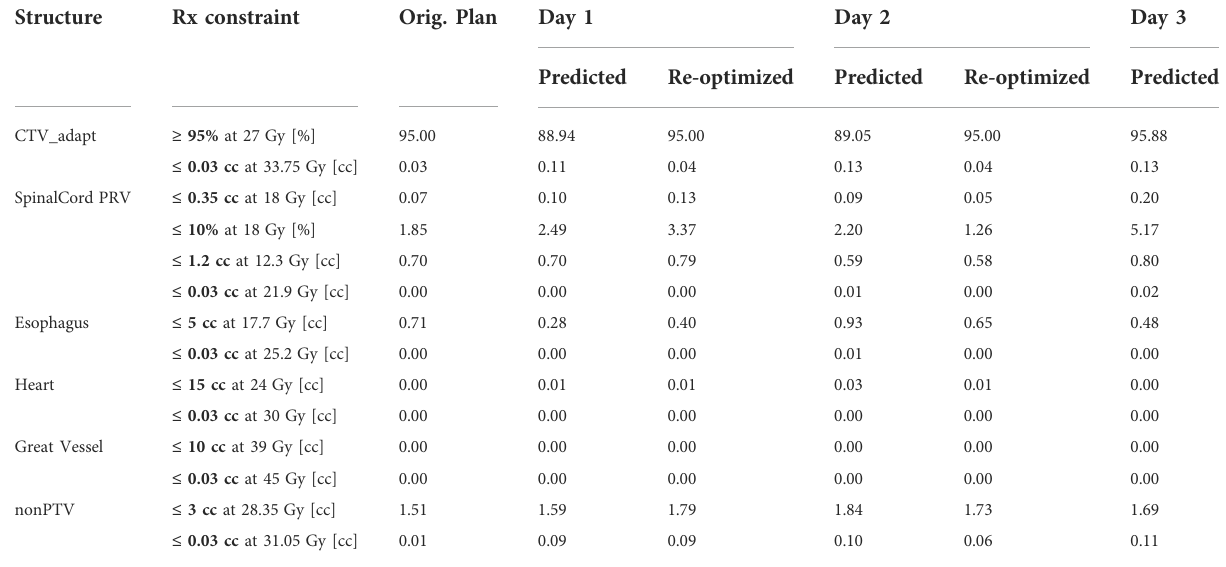
TABLE3Dosevolumecharacteristicsfortheoriginalplan,predicted,andre-optimizedplans,ifapplicableforeachofthethreefractionsdeliveredvia the ART work fl ow. Structure